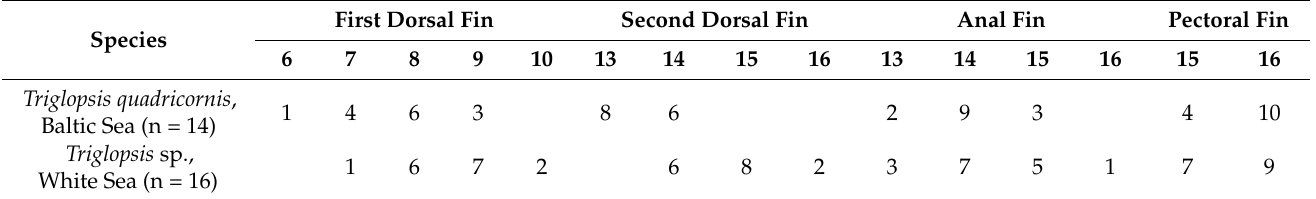
Table 2. Fin-ray counts for T. quadricornis from the Baltic Sea and Triglopsis sp. from the White Sea.